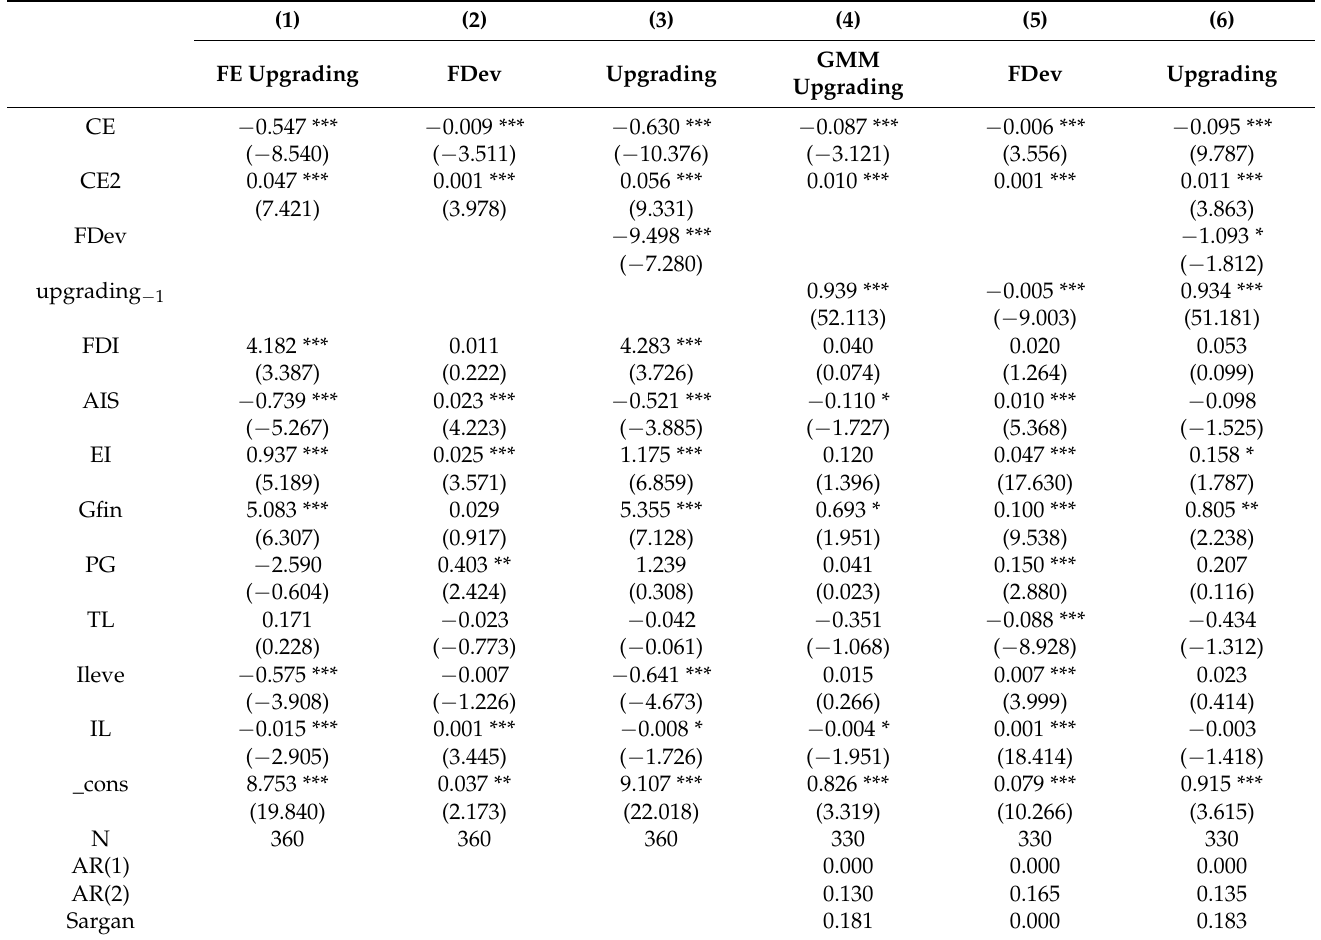
Table 4. Mechanism test results from the intermediary